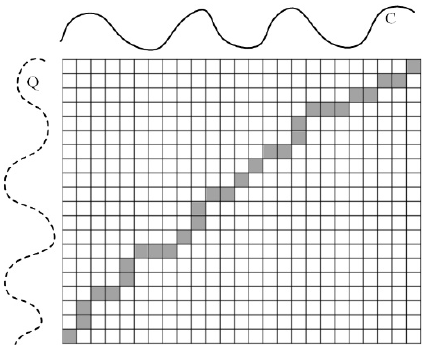
Figure 3: Calculate method of